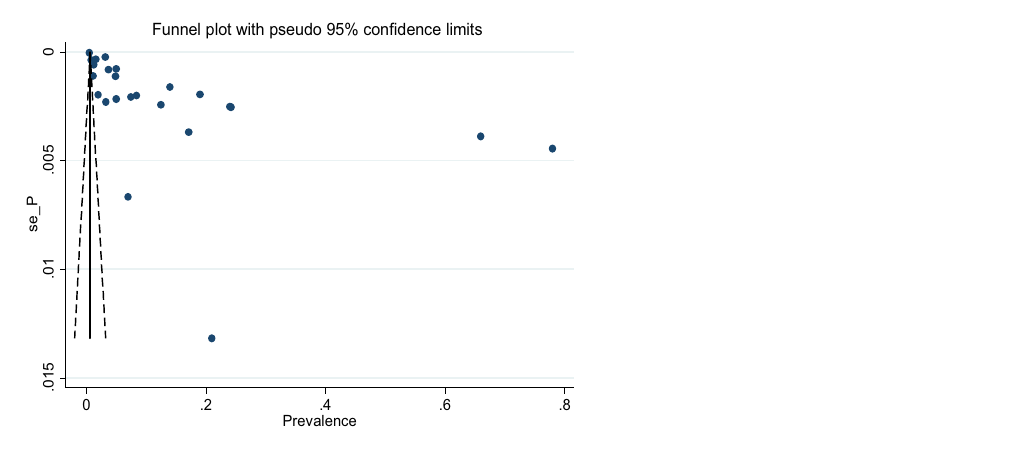
Figure 7. Meta-cumulative analysis of the prevalence of anencephaly in Africa, 2020.